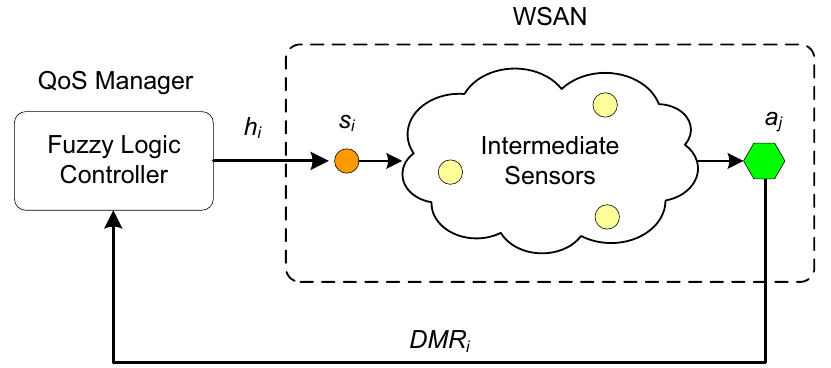
Figure 2. Fuzzy logic control based QoS